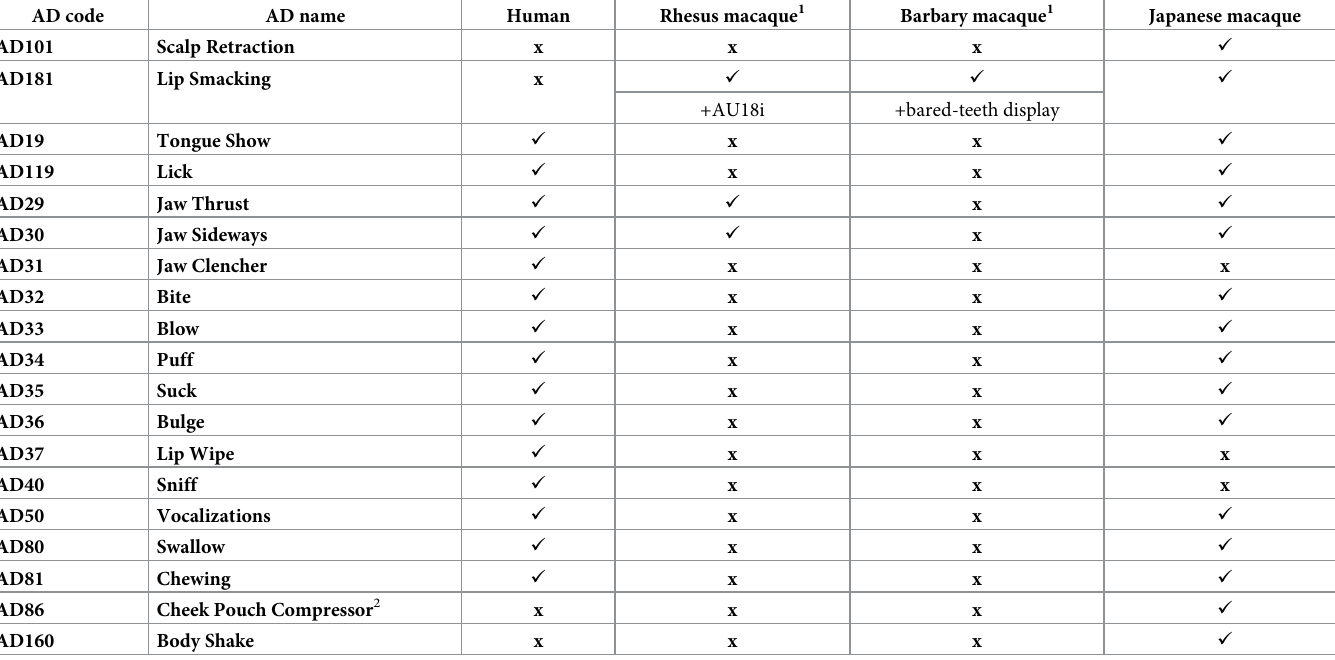
Table 3. Comparison between the Action Descriptors (ADs) previously included in the FACS developed for humans [67], rhesus [14] and Barbary [15] macaques, to what was here identified for Japanese macaques. AD